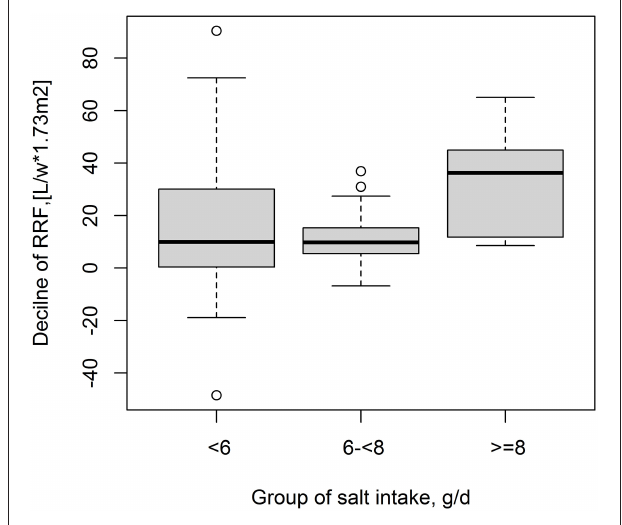
FIGURE 2 | Association between sodium excretion and decline of